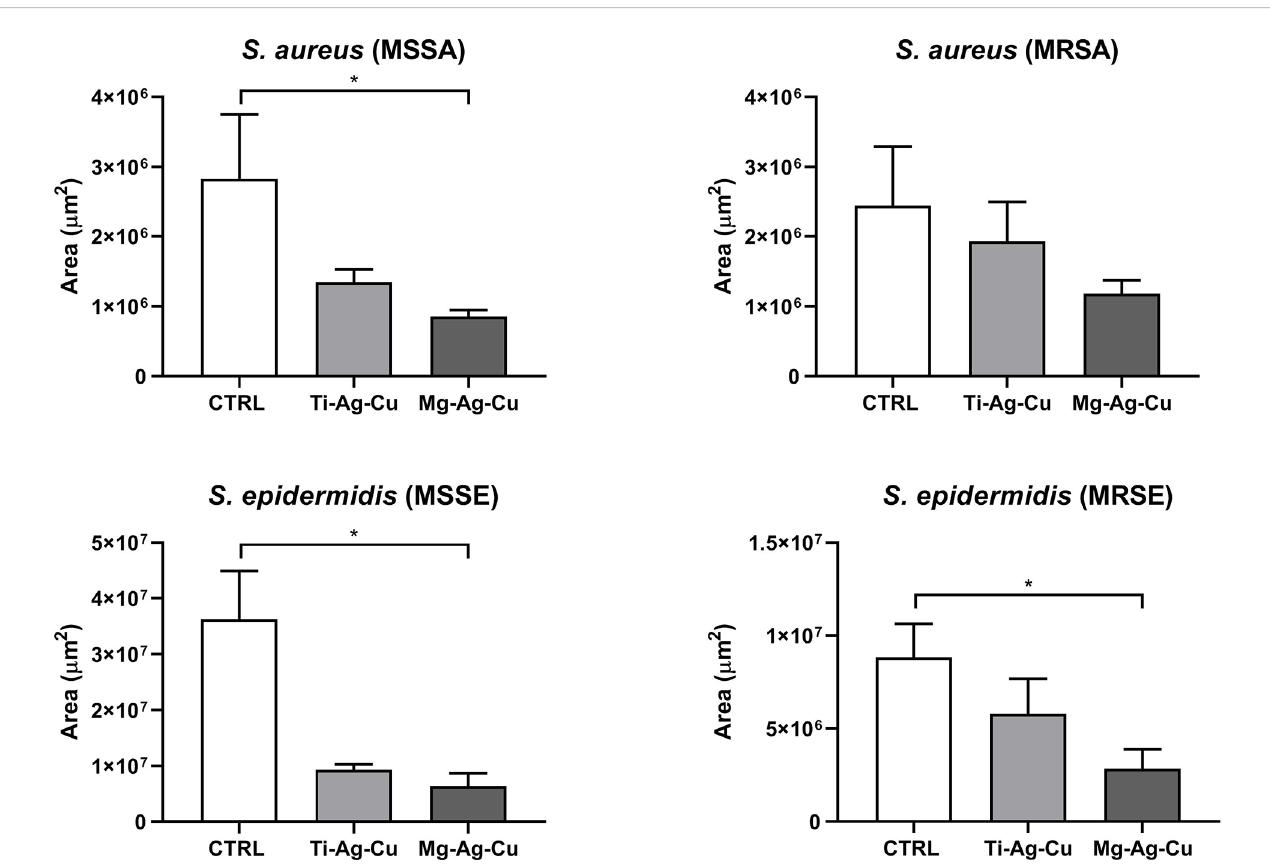
FIGURE 7 Effect of Ti-Ag-Cu and Mg-Ag-Cu coating S. aureus (MSSA and MRSA) and S. epidermidis (MSSE and MRSE) colonization compared to uncoated glass discs (CTRL) analyzed by means of CLSM. Statistical signi fi cance: p < 0.05